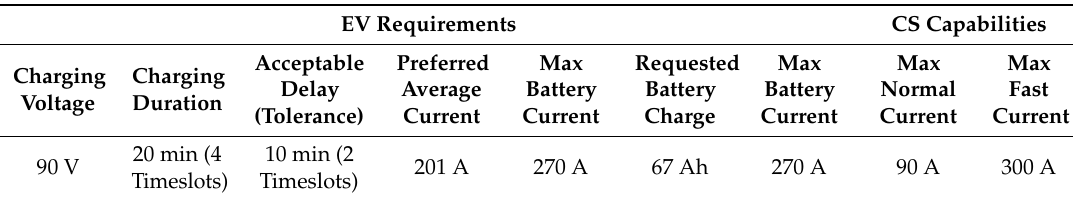
Table 1. The charging requirements of the electric vehicle (EV) and the capabilities of the charging station (CS).